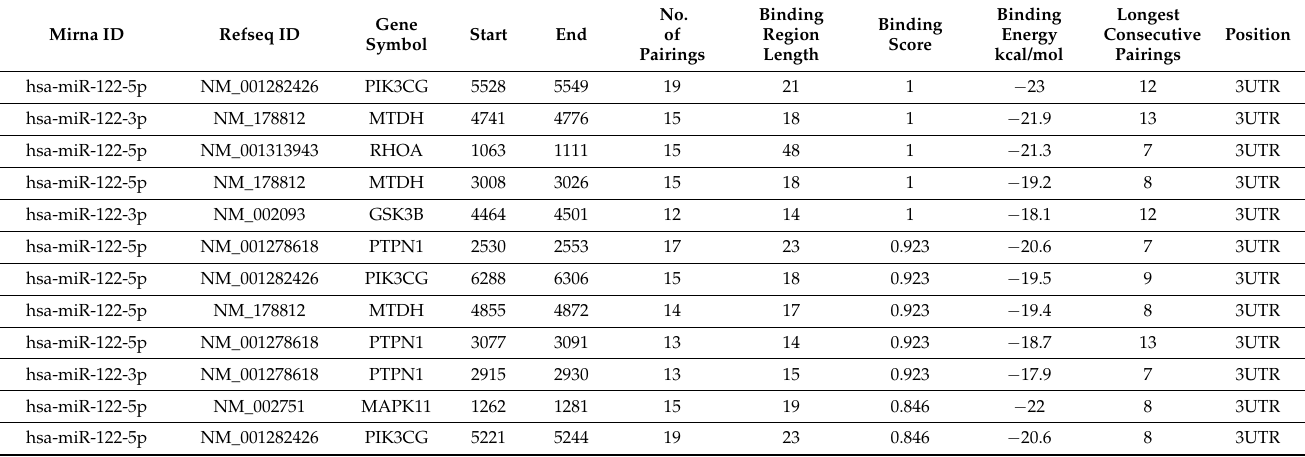
Table 2. Binding site prediction of miR122 and mRNA